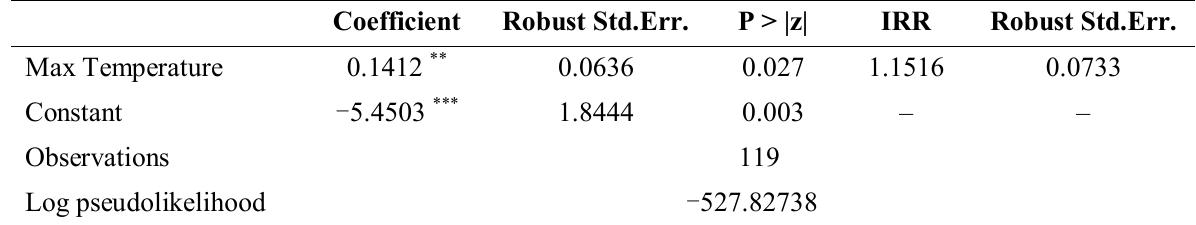
Table A2. Negative binomial model—Annual data (panel of regions): Cholera